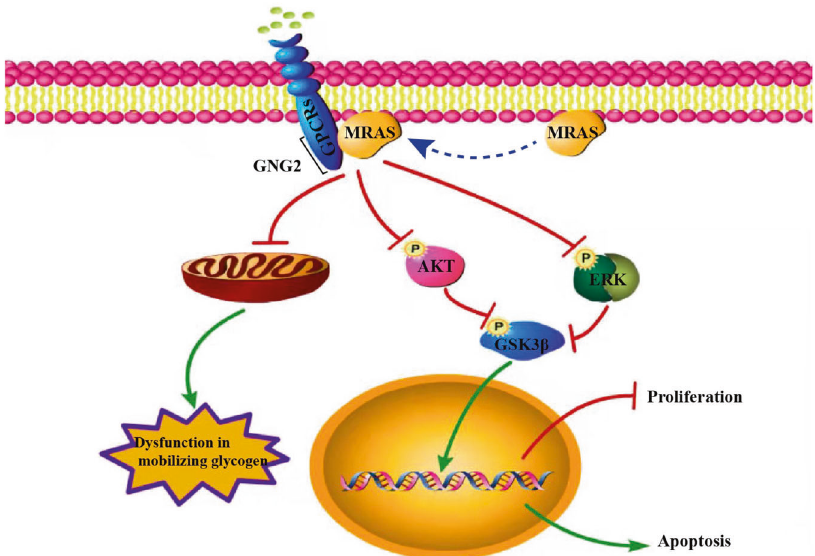
Fig. 8 Schematic diagram for the potential mechanisms of GNG2-mediated inhibition of tumorigenesis in BC. Green lines represent promotion, red lines represent inhibition, and dashed lines represent MRAS membrane